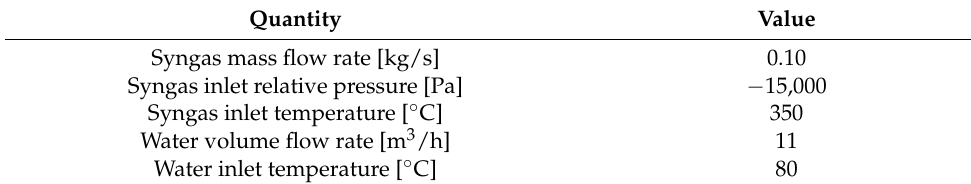
Table 1. Nominal operating conditions of the heat exchanger.